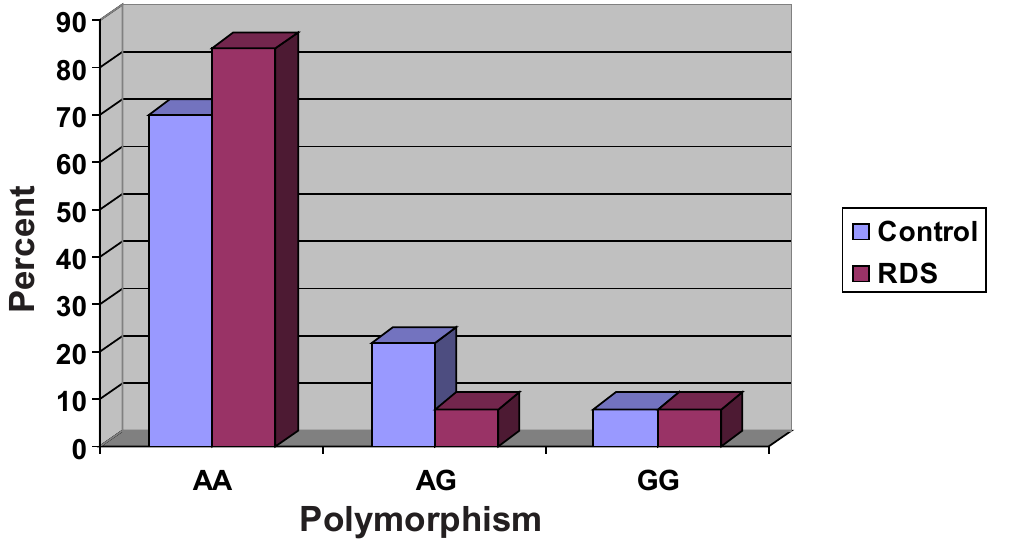
Figure 1. Frequencies of the A/G 9306 SP-B genotypes. Comparison between the respiratory distress syndrome (RDS) group (preterm newborns with RDS) and the control group (preterm newborns without RDS).